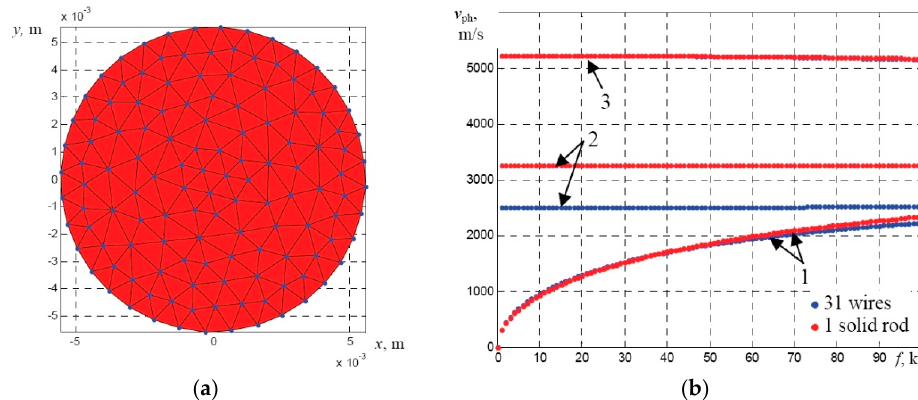
Figure 4. The mesh of the SAFE model of a strand that assumed to be equivalent to the bundle of solidly connected 31 wires having the overall diameter of 11.15 mm ( a ) and comparison of the phase velocity dispersion curves of the guided wave modes ( b ) propagating along the bundle of 31 wires ( blue ) and the solid rod of same diameter ( red ): 1—flexural-like F (1,1) mode; 2—torsional-like T (0,1) mode; 3—axial-like L (0,1) mode.